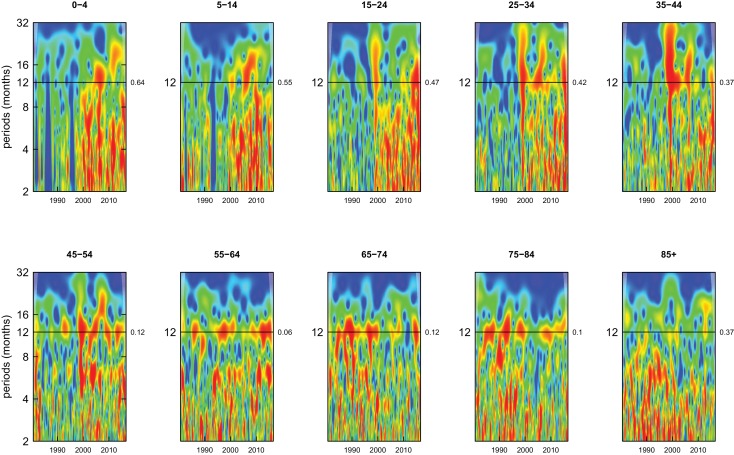
Wavelet power spectra for national time series of substance use disorder death rates for 1980–2016, by age group for males.Wavelet power values increase from blue to red. The shaded regions at the left and right edge of each box indicate the cone of influence, where spectral analysis is less robust. P-values for the presence of 12 month seasonality are to the right of each figure at the 12 month line.